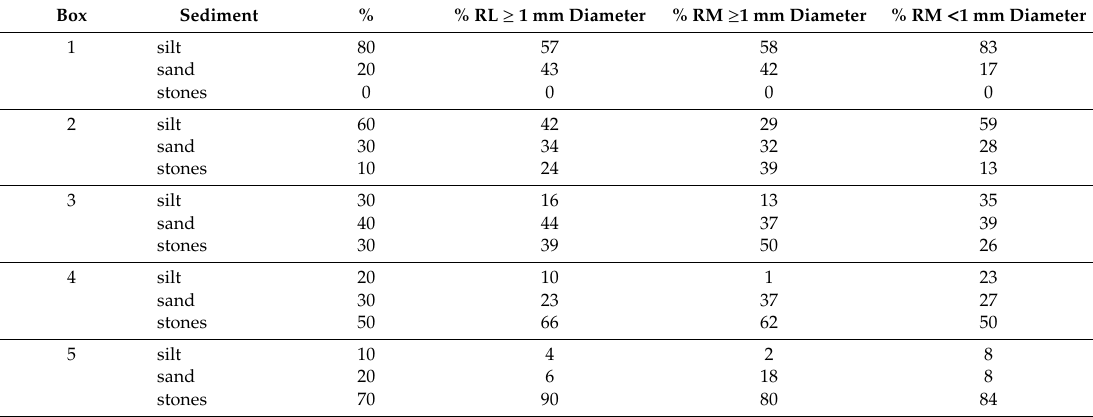
Table 3. The proportion of root length (RL; roots with diameter ≥ 1 mm) and root mass (RM) of coarse roots (diameter ≥ 1 mm) and fine roots (diameter < 1 mm) found in the di ff erent proportions of sediment in each box.